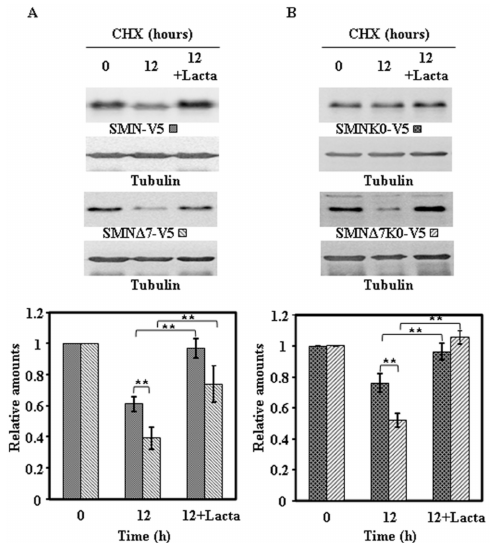
Figure 8. Effect of proteasome inhibition on the degradation of ectopically expressed SMN-V5 or SMN ∆ 7-V5 constructs in HeLa cells. Transiently transfected HeLa cells, with SMN-V5 or SMN ∆ 7-V5 ( A ) and SMNK0-V5 or SMN ∆ 7K0-V5 ( B ) were treated with CHX in the absence or in the presence of Lactacystin (Lacta) for the indicated times and cell extracts were analyzed by immunoblot with anti-V5 specific antibodies. Anti-tubulin antibodies were used as total protein loading control. The graphs below show the quantification of the corresponding immunoblots. Values are expressed as mean ± S.E.M. from three different experiments. Asterisks indicate a statistical significant difference between pairs (** p < 0.01, Student’s t -test). n.s., not